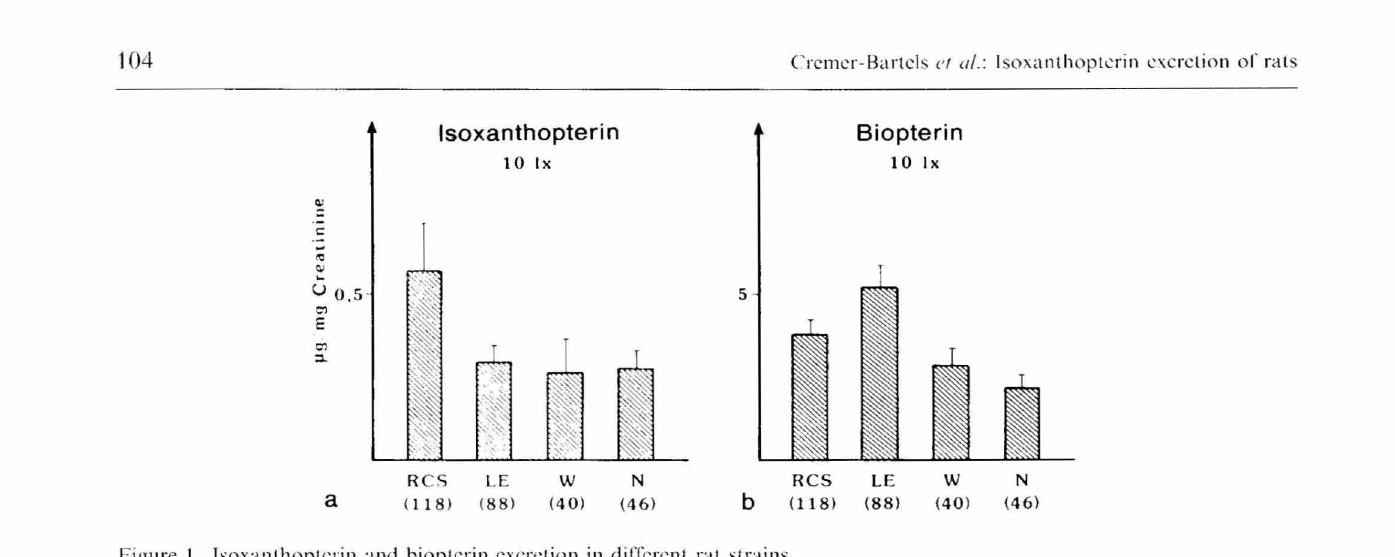
Figure I. Isox<lnthoptCiin and hioptcrin cxcretion in dirlCrcnt rat strains. a) isox<lnthopterin. RCS Royal Collegc or Surgcons: LE Long Evans: W Wistar; N Norwegian. b) Bioptcrin. In parcnthcsis the numher of measurcments.